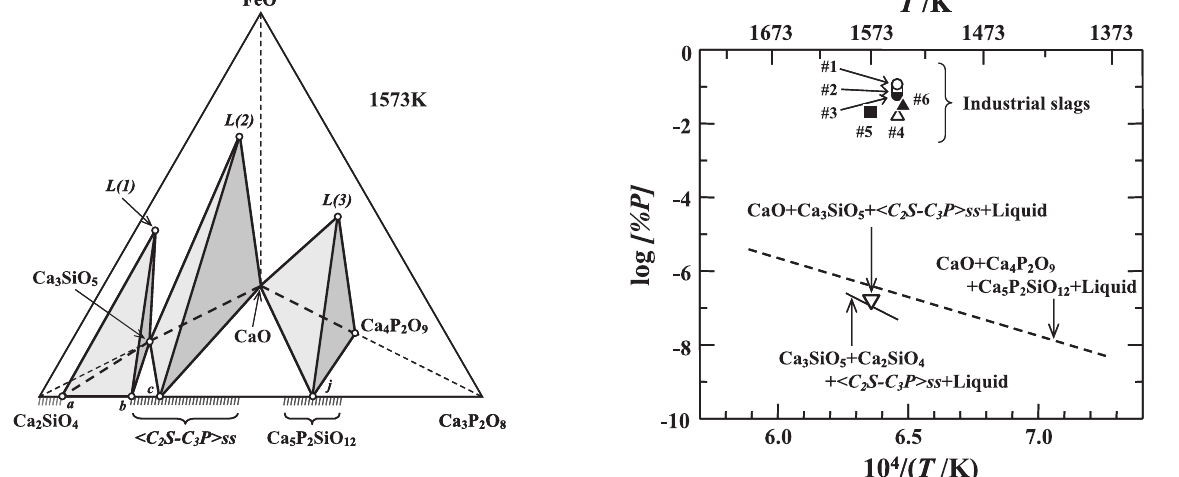
SiO - Fig. 6: Estimated phosphorus contents in molten 2 4